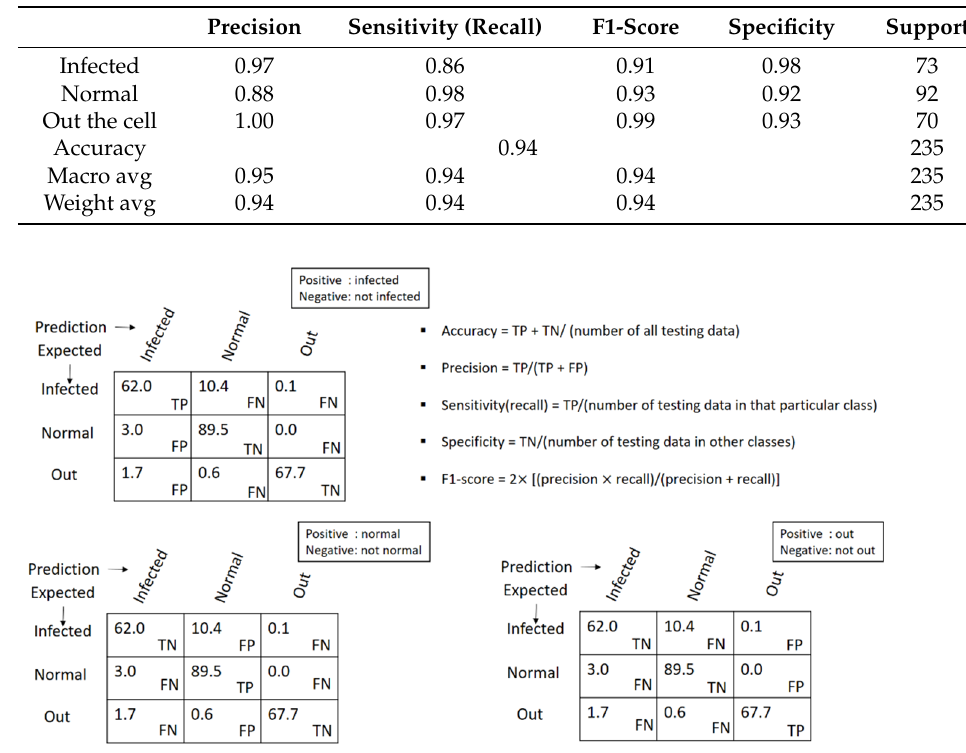
Table 2. List of parameters presenting how well the infected cells were distinguished from normal cells and non-cell area spectra (evaluated by 20% split data from training data set).